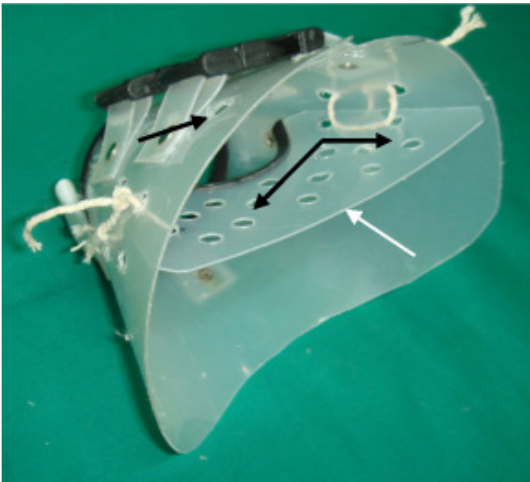
FIGURE 5 - Detail of the course of the attachment band on the side of the thorax from one side to the other (band seen from the right side) and on the ventral area through the back paws of the animal (traced). The half moon cut allows the animal to feed freely